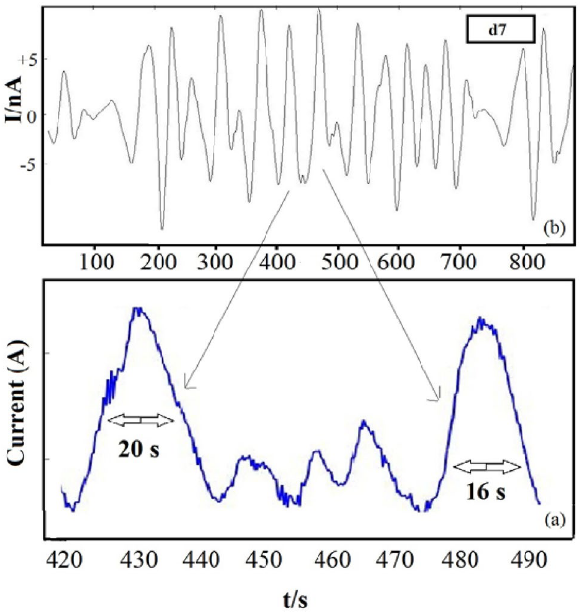
Figure 7. ( a ) The d7 partial signal, ( b ) part of the Asy original signal illustrated in Fig. 5.